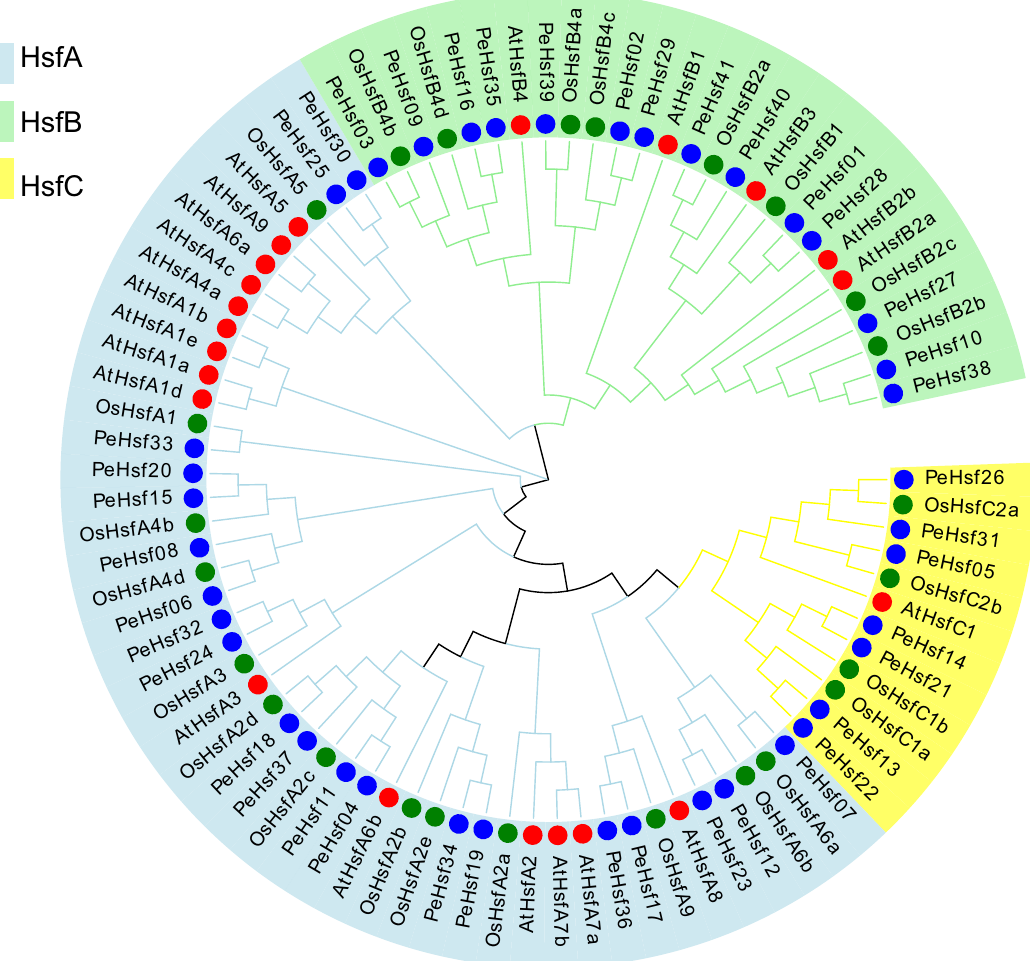
Figure 1. Phylogenetic analysis of full-length HSF protein sequences from Phyllostachys edulis (Pe, bamboo), Arabidopsis thaliana (At, Arabidopsis), and Oryza sativa (Os, rice). ClustalX was used to build a multiple sequence alignment, and MEGA7.0 (https:// www. megas oftwa re. net/) was used to construct a maximum likelihood (ML) phylogenetic tree with 1000 bootstrap replicates. Blue, red, and green circles indicate bamboo, Arabidopsis, and rice sequences, respectively. Evolview (https:// evolg enius. info// evolv iew- v2/# login) online URL for